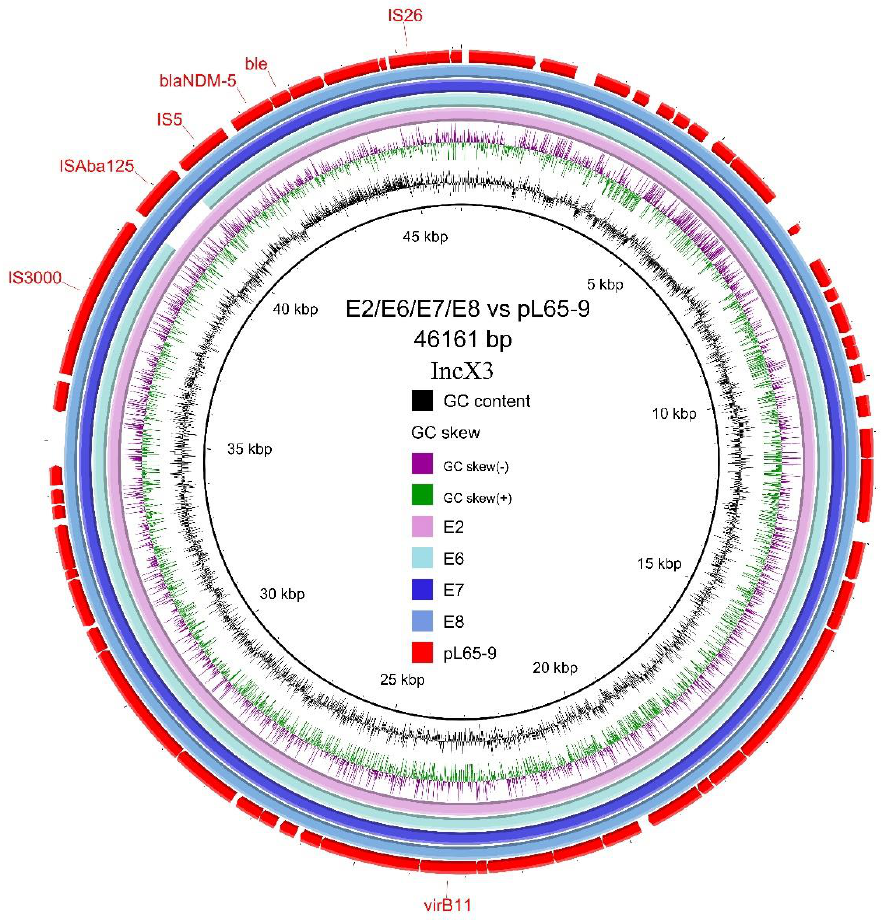
Figure 4. Circular alignments of the reference plasmid sequence (pL65 − 9, GenBank accession: CP034744) with homologous bla NDM-5 -carrying contigs from the E. coli strains E2, E6, E7 and E8 in this study. Representative genes such as antimicrobial resistance genes and mobile genetic elements are labelled in the outermost circle.